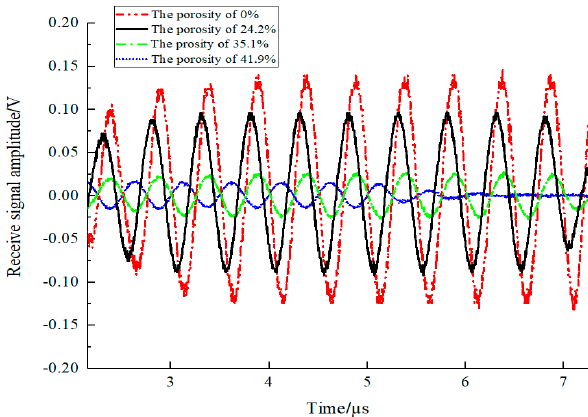
Figure 7. Time domain diagram of received signals for different samples.